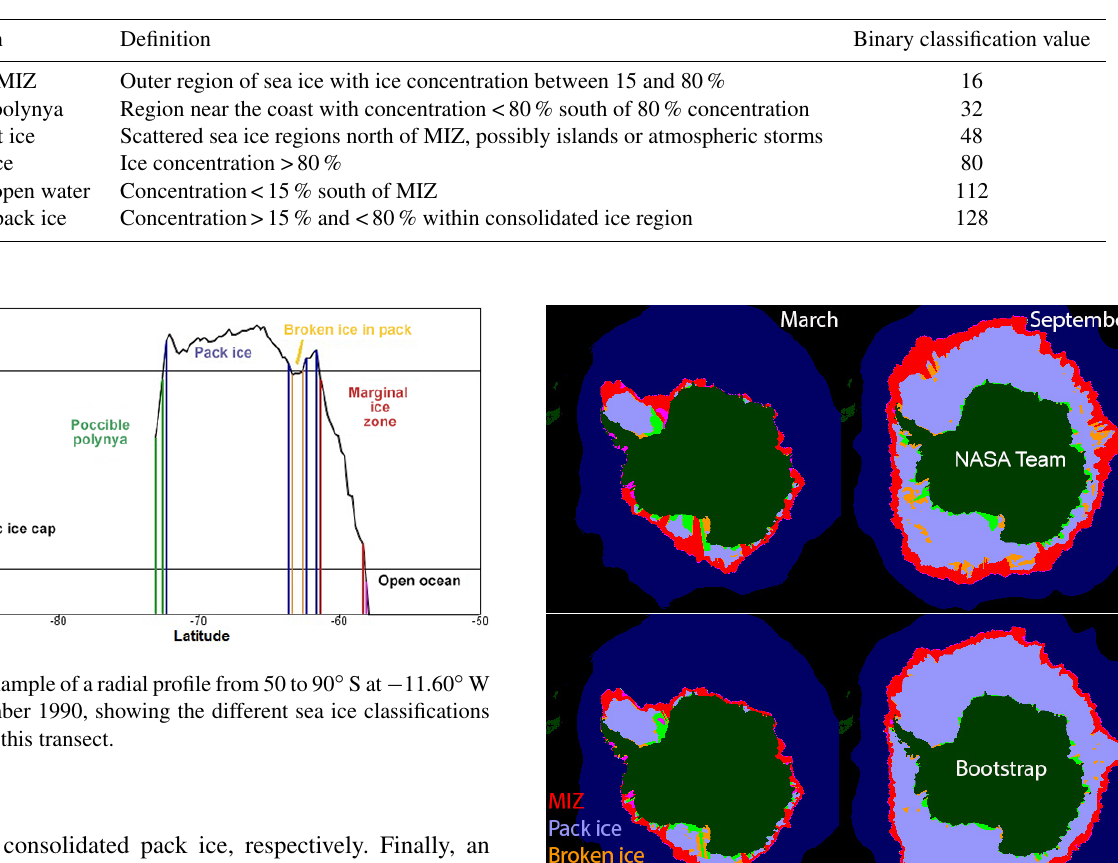
Table 1. Sea ice categories defined in this study.